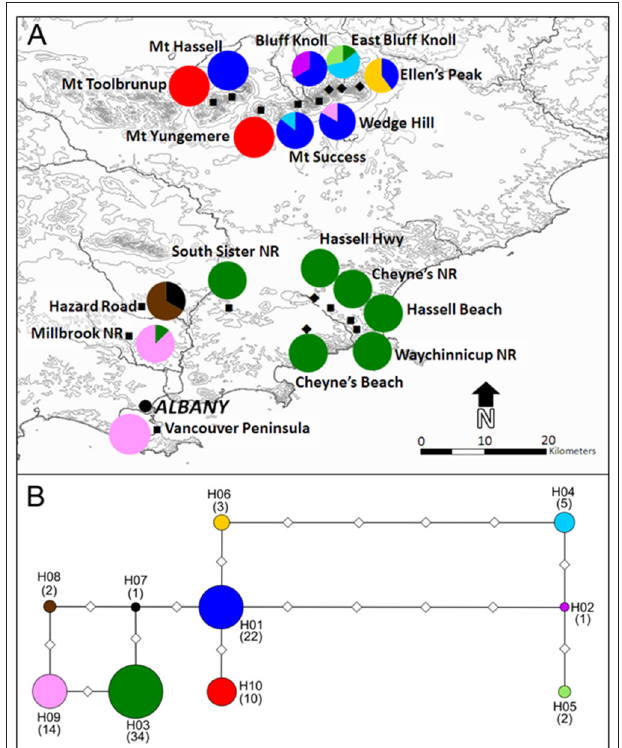
FIGURE 1 | Location of sampled populations of Banksia brownii and distribution of haplotypes within populations (A) and haplotype network (B) . Population locations represent extant (squares) and extinct (diamonds) populations and haplotype frequencies are represented by pie charts for each population. Color-coding of haplotypes on the map corresponds to those in the median-joining maximum parsimony haplotype network. Diamonds on the network branches represent mutations between haplotypes and circle sizes are relative to haplotype frequencies with number of individuals with each haplotype given in parentheses below haplotype